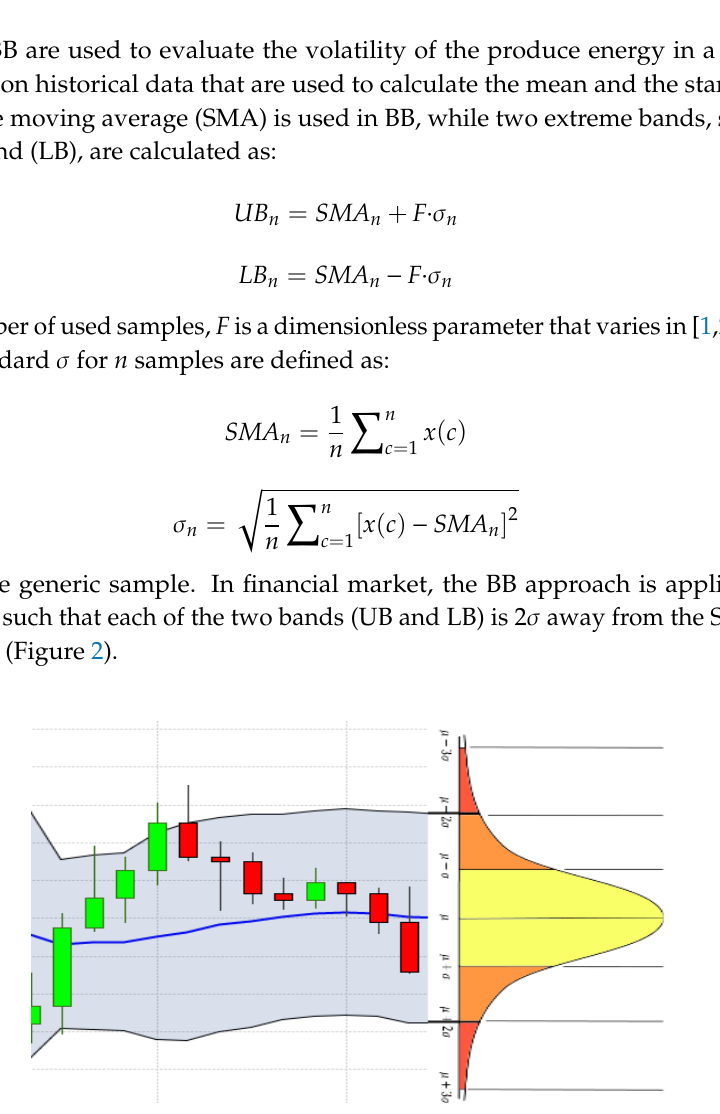
Figure 2. Stock price, middle band (simple moving average (SMA) in blue), upper band (UB) and lower band (LB) 2𝜎 away from the SMA. Figure of Albert Callisto, CC BY-SA 4.0, https://commons.wikimedia.org/w/index.php?curid=52884453.